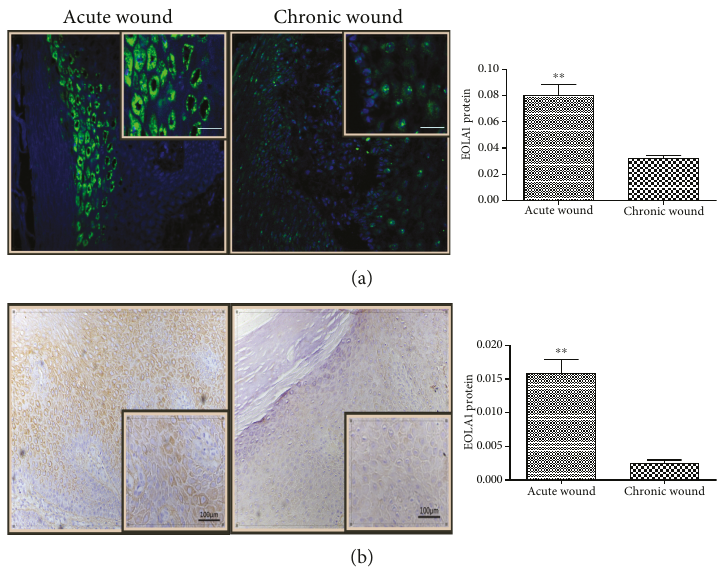
Figure 2: EOLA1 expression in the epidermis of diabetic foot skin tissues. The expression of the chronic wound was obviously decreased. (a) EOLA1 protein (green) identi fi ed by immuno fl uorescence. Cell nuclei were detected by DAPI (blue). Scale bar: 100 μ m. (b) Immunohistochemical analysis of EOLA1 in the diabetic foot skin tissues. The yellowish-brown color denotes the positive areas. The quantitative analysis of EOLA1 expression was performed through measuring the average optical density. ∗∗ P < 0 01